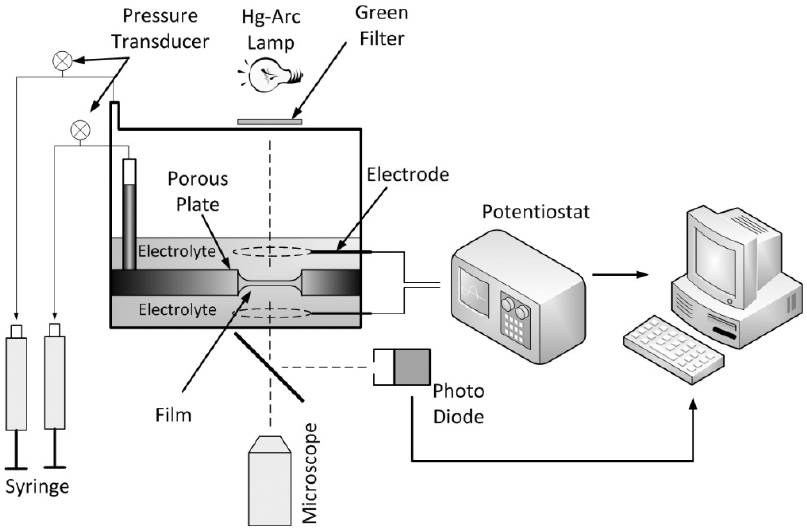
Figure 1. Schematic diagram of the experimental